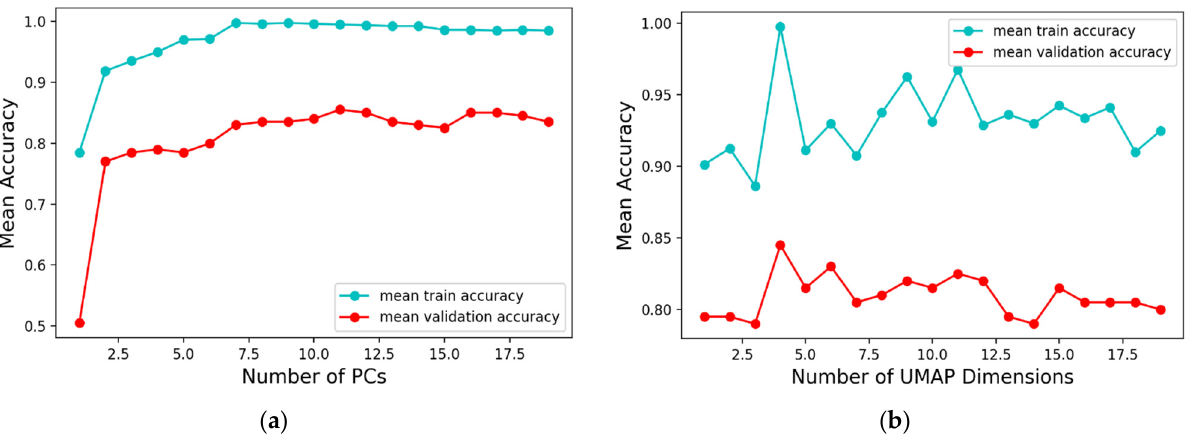
Figure 4. ( a ) Comparison of different number of principal components from PCA with the model’s mean accuracy across 10 folds ( b ) Comparison of different number of components from UMAP with the model’s mean accuracy across 10